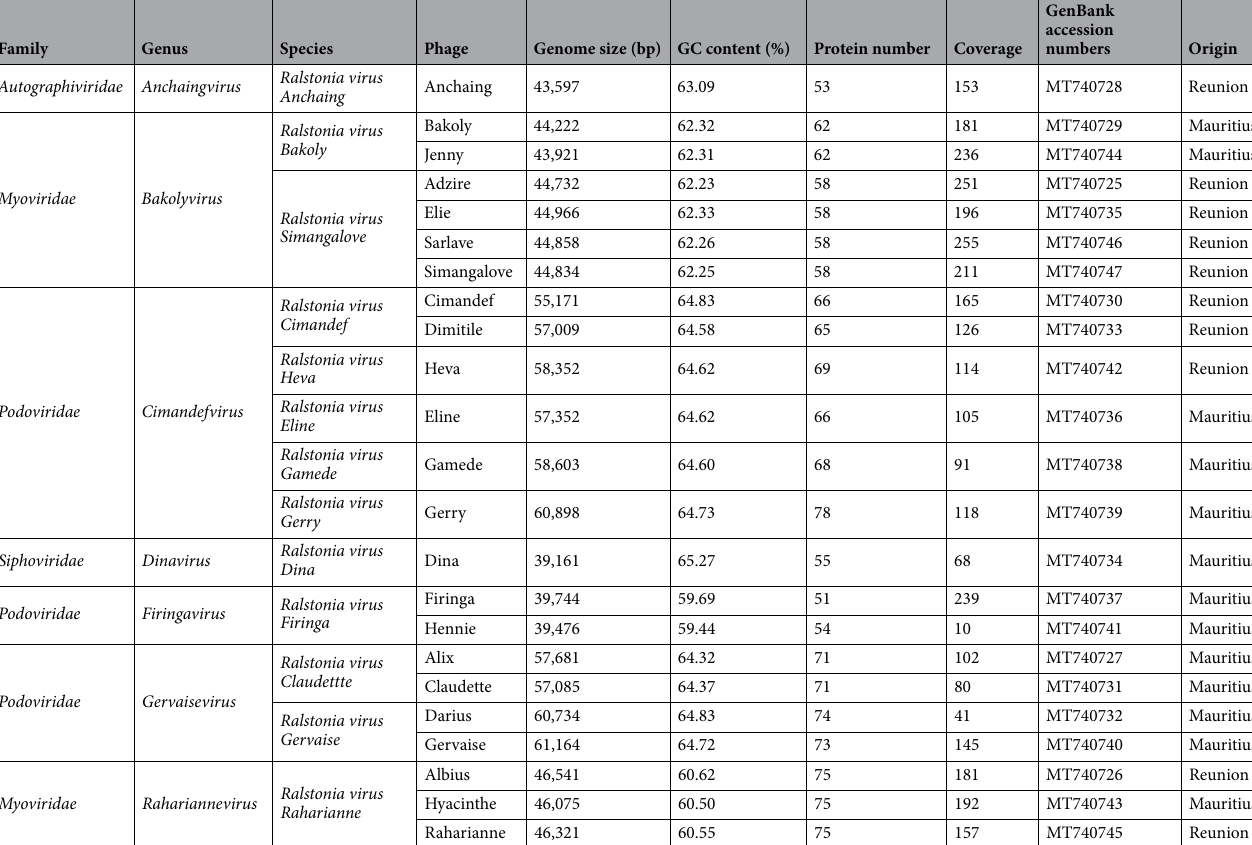
Table 1. Taxonomic and genomic features of 23 newly isolated R. solanacearum phages. Italics lines indicate phage clones from Reunion and white ones phages from